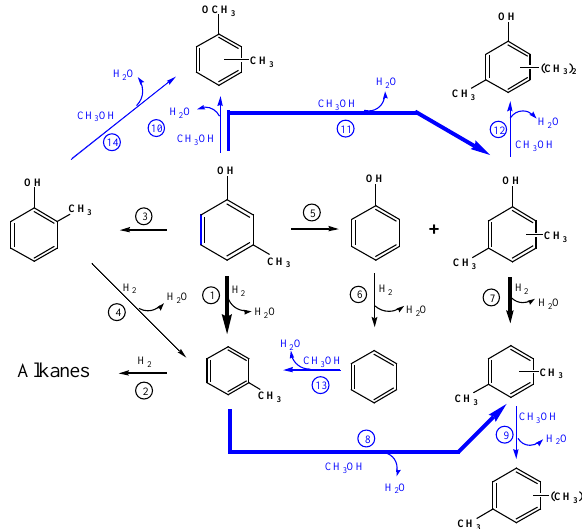
Figure 6. A possible reaction routes for catalytic hydrodeoxygenation and methylation of m- cresol over Pt/HZSM-5. The blue line represents the reaction involved in methanol.